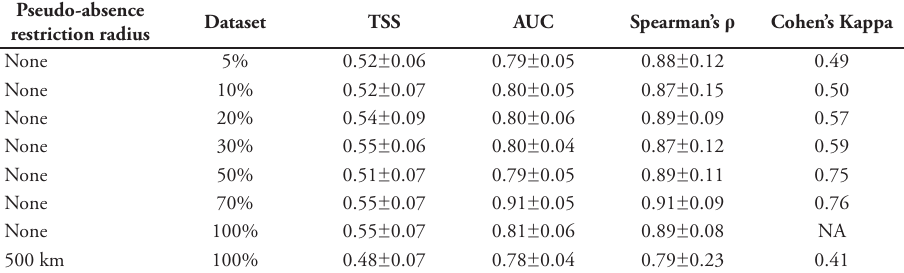
Table 1. Summary statistics for Species Distribution Models (SDMs). ‘Dataset’ indicates the percent- age of the African distribution data that were sub-sampled. AUC and TSS indicate predictive accuracy. Mean (±standard deviation) TSS and AUC values are averages calculated by internal cross-validation for all SDMs constructed with each dataset, excluding SDMs that were discarded in making the en- semble due to low predictive accuracy (TSS <0.4). TSS values between 0.4 and 0.5 are often considered ‘moderate’(Landis and Koch 1977). AUC values between 0.7 and 0.8 are often considered “fair”. Spear- man’s ρ is calculated between the global ensemble projections made using 70% (used for internal cross- validation) and 100% of the data and indicates whether the validation statistics can be considered repre- sentative of the final model. Cohen’s Kappa measures the agreement between the global ensemble forecast using 100% of the distribution data and the entire background and the named dataset. Kappa values of